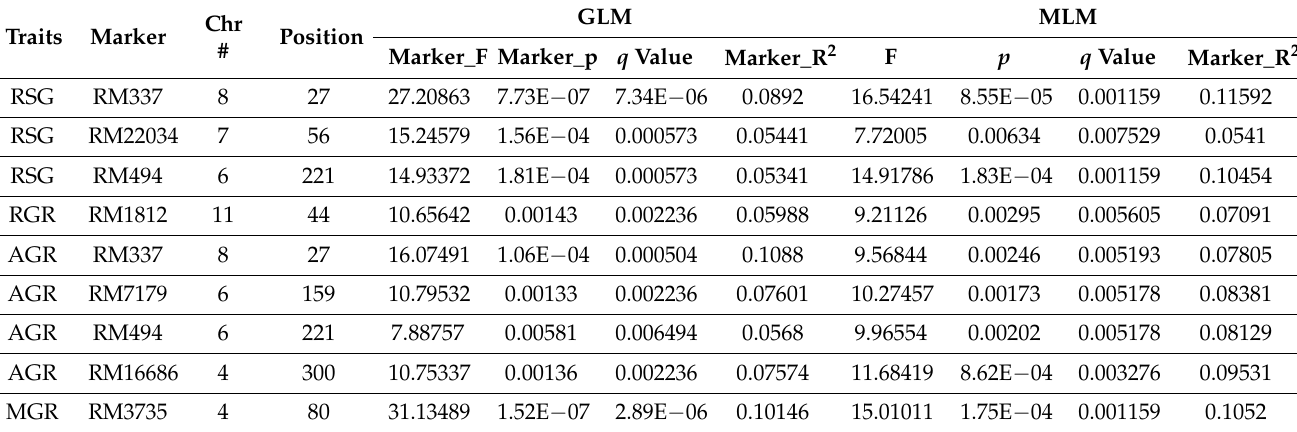
Table 4. Marker alleles’ association with germination rate and early seedling growth parameters in the rice germplasm lines present in the panel population detected by both GLM and MLM analyses at p <